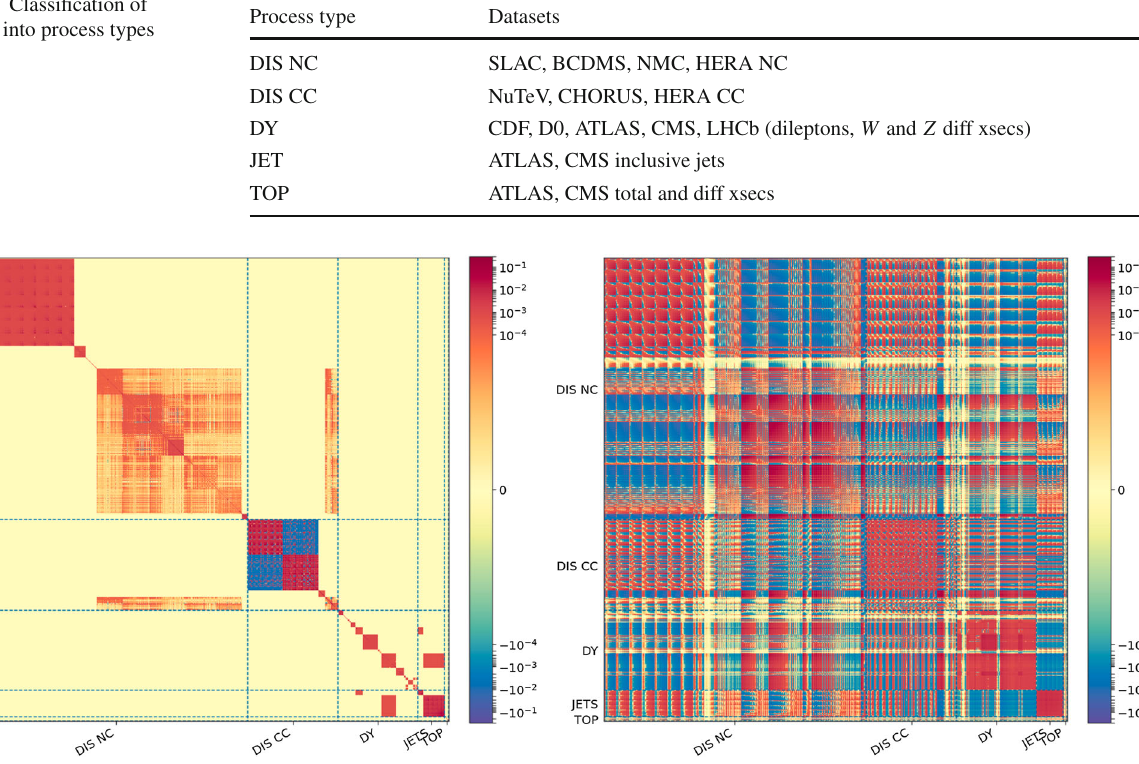
are arranged in the order given in Fig. 7 below: so SLAC data ( 0 ) are in the top left corner, and LHC top data in the lower right (left), and the cor- (cid:12) i X ii X jj (right). The datasets